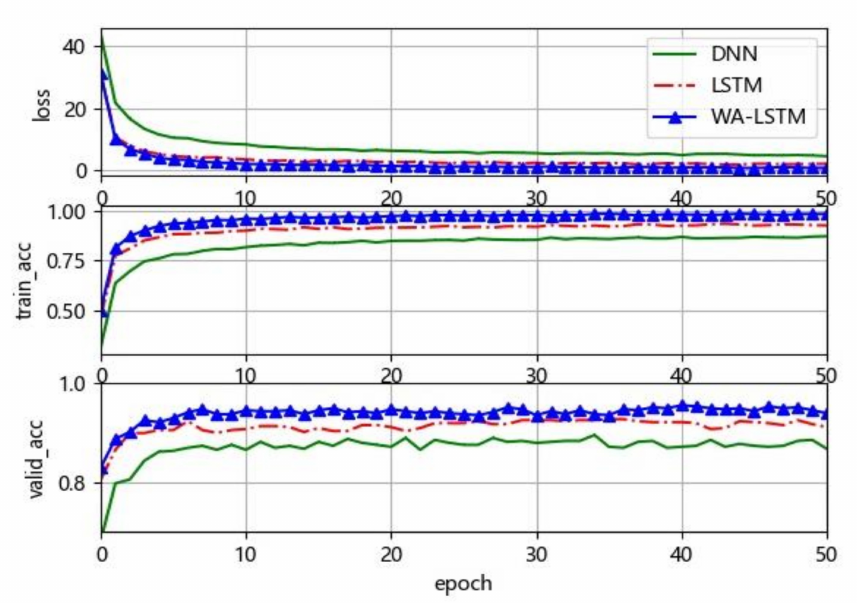
Figure 6. Comparison of experimental loss and accuracy between three groups.